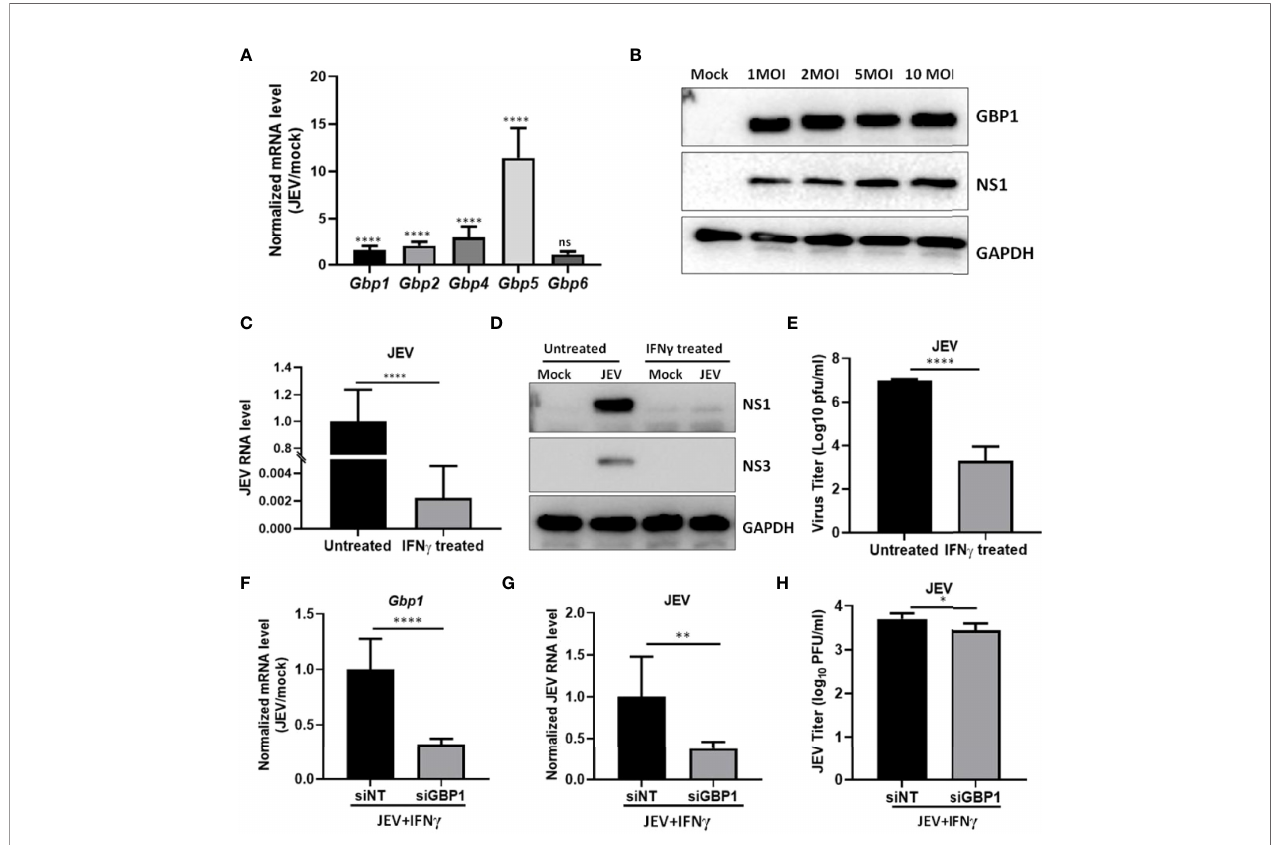
FIGURE 4 | GBP1 expression is upregulated during JEV infection and its depletion reduces JEV replication in an IFN g primed environment in SH-SY5Y cells. (A) SH-SY5Y cells were mock or JEV infected at 1 MOI for 24 h, and mRNA levels of Gbps were quanti fi ed by qRT-PCR. Graph shows the relative expression level of gene transcripts in mock and JEV infected samples. (B) SH-SY5Y cells were mock or JEV infected at 1, 2, 5 and 10 MOI for 24 h, cell lysates were analyzed by western blotting with JEV non-structural protein (NS1), GBP1 and GAPDH (loading control) antibodies. (C – E) SH-SY5Y cells were mock or IFN g (10 ng/ml) treated for 12 h followed by JEV infection at 1 MOI. At 24 hpi, cells were harvested for RNA isolation or cell lysate preparation, and supernatant was collected to quantitate virus titer. (C) JEV RNA level was analyzed by qRT-PCR, (D) Western blots showing the levels of JEV-NS3, JEV-NS1 and GAPDH (loading control), (E) Bar graph showing the virus titer determined by plaque assays. (F – H) SH-SY5Y cells were transfected with NT/GBP1 siRNA for 48 h, followed by IFN g treatment for 12 h and then mock or JEV infected at 1 MOI. At 24 hpi total RNA was isolated and GBP1 mRNA (F) , and JEV RNA, (G) levels were determined by qRT-PCR. (H) Virus titer was determined by plaque assays. Data presented is mean ± SD of values obtained from 3 independent experiments. Student t-test was used to calculate P values. * P < 0.05, ** P < 0.01, **** P < 0.0001. ns, Non signi fi